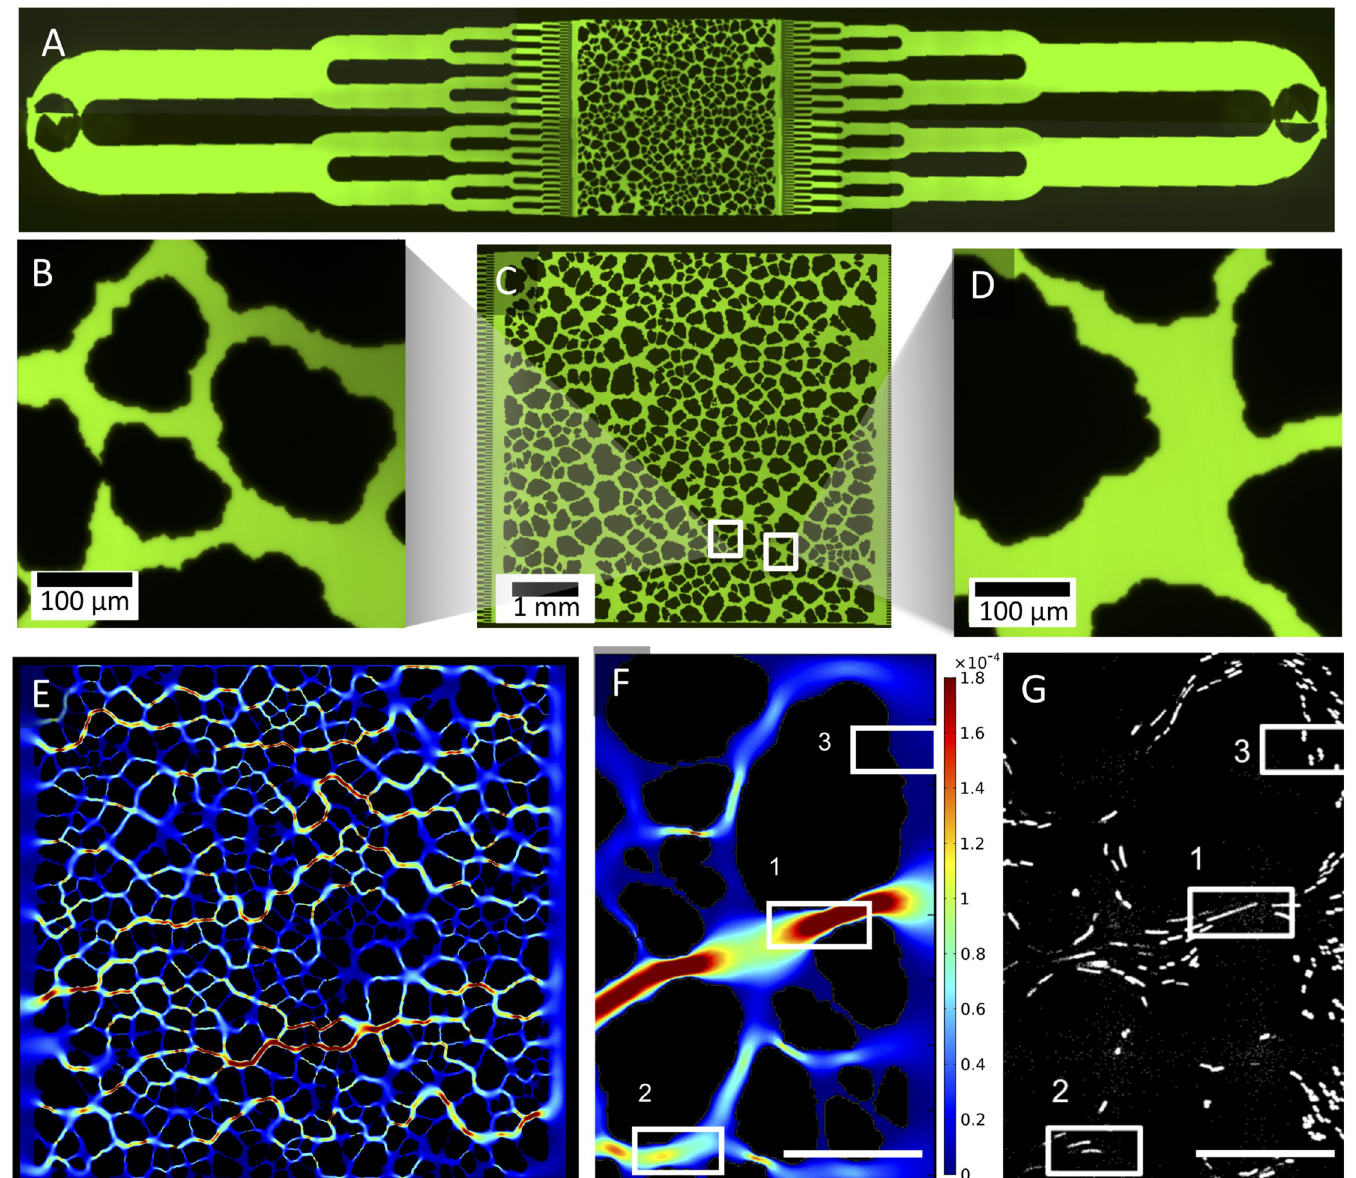
Fig 1. A microfluidic platform replicates the natural shape and layout of sand grains. (A) The device, filled with fluorescein to highlight its features, has a bifurcating inlet and outlet to uniformly distribute bacterial cells across the design (C) The porous network design (approximately 6,000 x 6,000 x 10 um) consists of heterogeneous pore spaces that have (B) constriction points smaller than the size of a bacteria cell and (D) larger, highly connected pore spaces. (E) Velocities within the pore space were simulated using COMSOL Multiphysics, which illuminated multiple preferential flow paths across the system. (F,G) The pore space velocities were experimentally verified using particle image velocimetry and velocity magnitudes (F, regions 1, 2, 3, decreasing in magnitude) corresponded to bead speeds within the same pore (G, regions 1, 2, and 3)(scale bars = 100 μ m, velocity units = m/s). https://doi.org/10.1371/journal.pone.0218316.g001 no significant difference in flow rate change compared to the WT strain. However, change in flow rate over time in this heterogeneous porous network was drastically different than the abrupt, catastrophic clogging that other researchers have seen from similar experiments in a single tortuous channel[26]. Presumably, this is because, as bacteria obstruct one preferential flow path, other preferential flow paths open up and divert flow around the clog. This